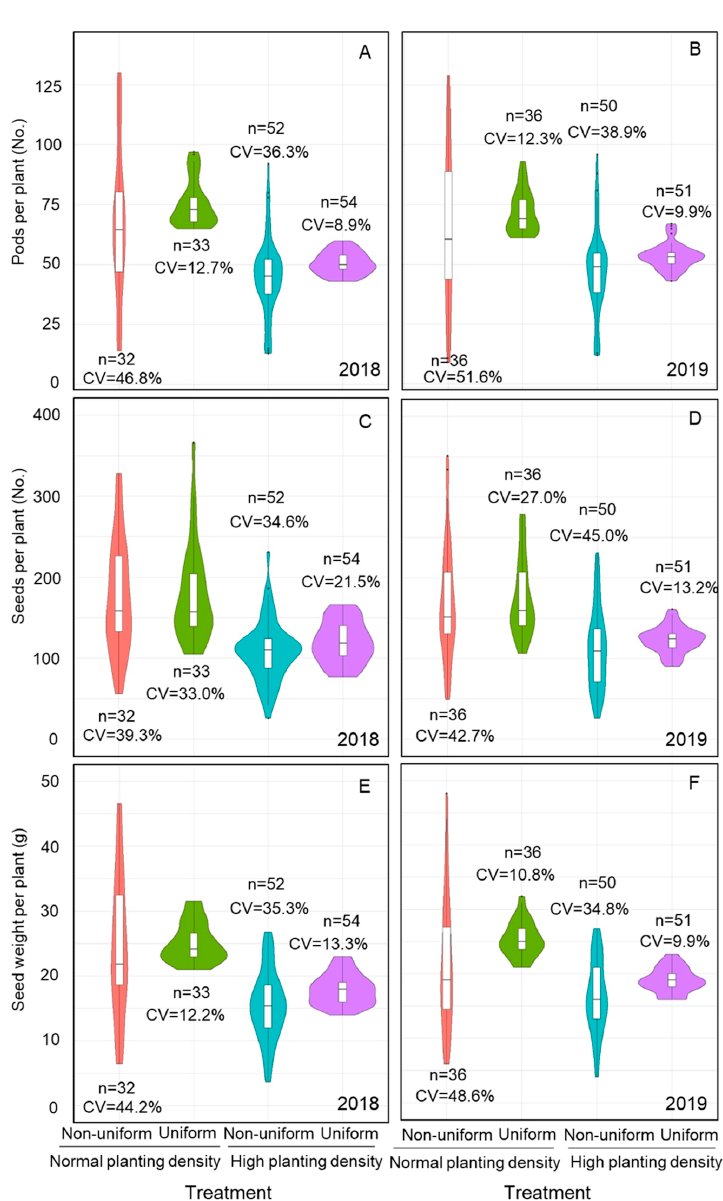
Figure 3. Effects of plant distribution on plant productivity of soybean under different planting densities. CV, coefficient of variation. ( A , B ) The pods per plant in the 2018 and 2019 growing seasons, respectively. ( C , D ) The seeds per plant in the 2018 and 2019 growing seasons, respectively. ( E,F ) The seed weight per plant in the 2018 and 2019 growing seasons, respectively.